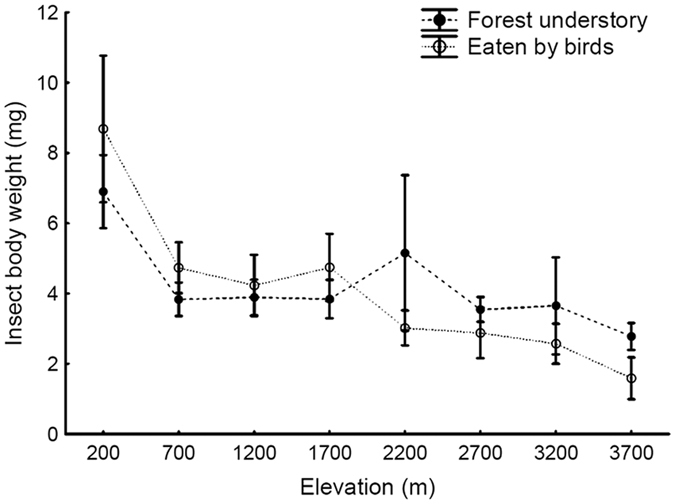
Arithmetic mean (±SE) of body weight (log grams) of insect collected in forest understory by insecticide spraying and found in food samples of mist-netted birds.